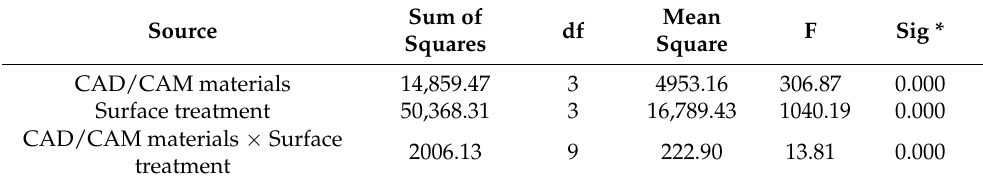
Table 5. MANOVA outcome for